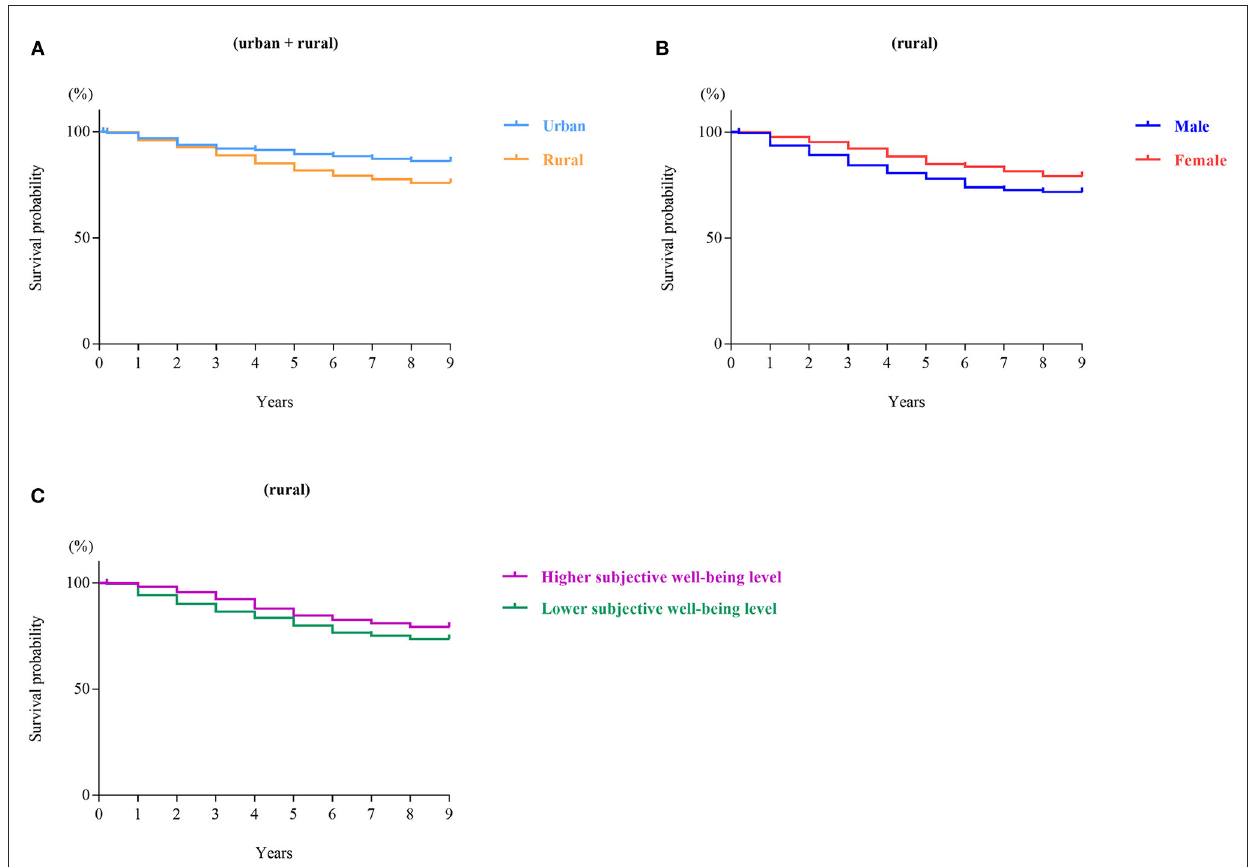
FIGURE2 Survival curves among Chinese elderly people in urban/rural areas. (A) Urban + rural, (B) rural, (C) rural.